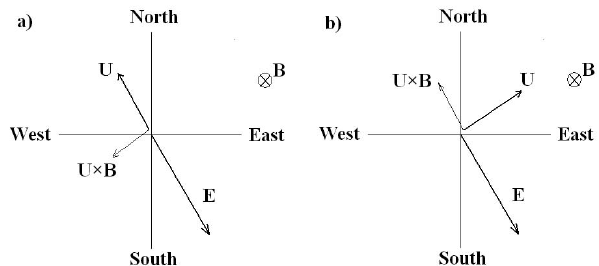
Fig. 11. Schematic illustration which shows a relationship between the neutral wind U , electric field E , and U × B in the northern high latitude region in cases; (a) U blows in the direction opposite to E and (b) U blows in the direction perpendicular to E